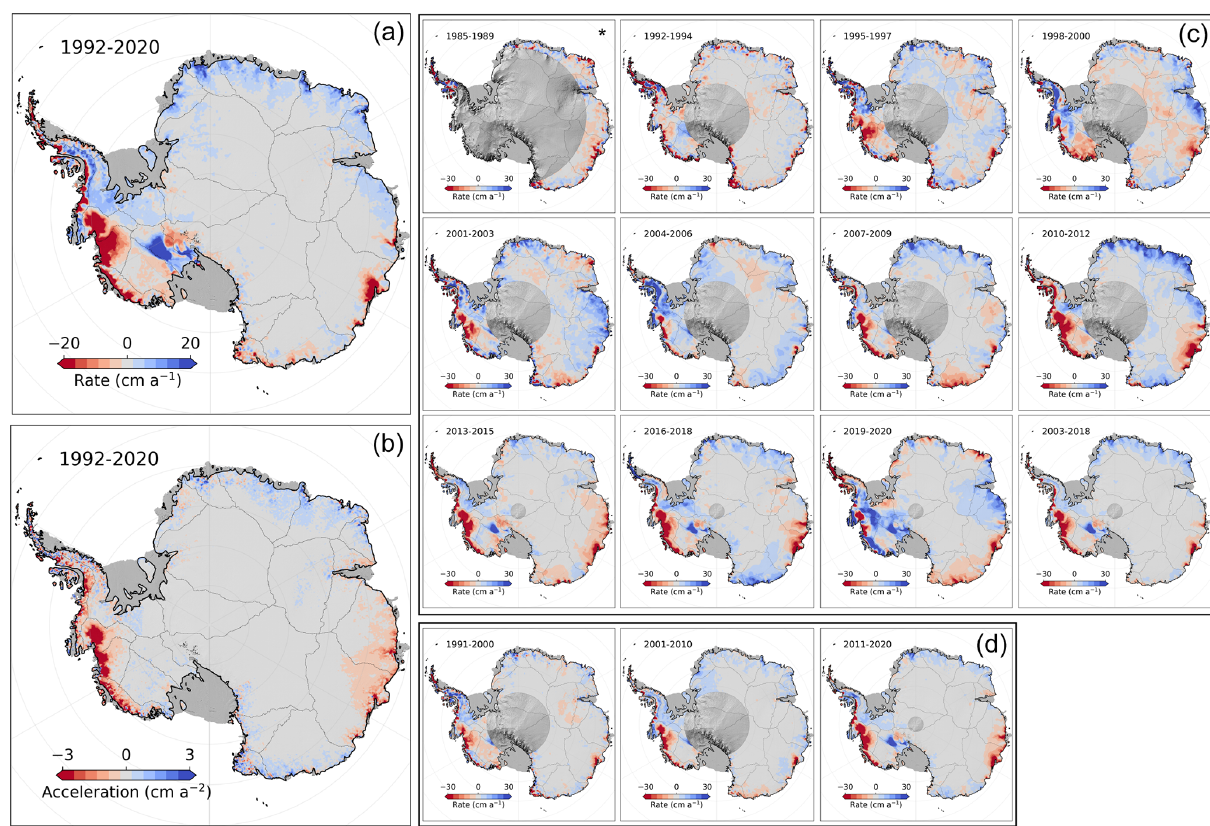
Figure 10. Rates of Antarctic Ice Sheet elevation change. Elevation change rate (a) and acceleration (b) for the 1992–2020 period and average rates for (c) 3-year, (d) ICESat and ICESat-2, and (d) 10-year intervals. The * indicates a 5-year interval for